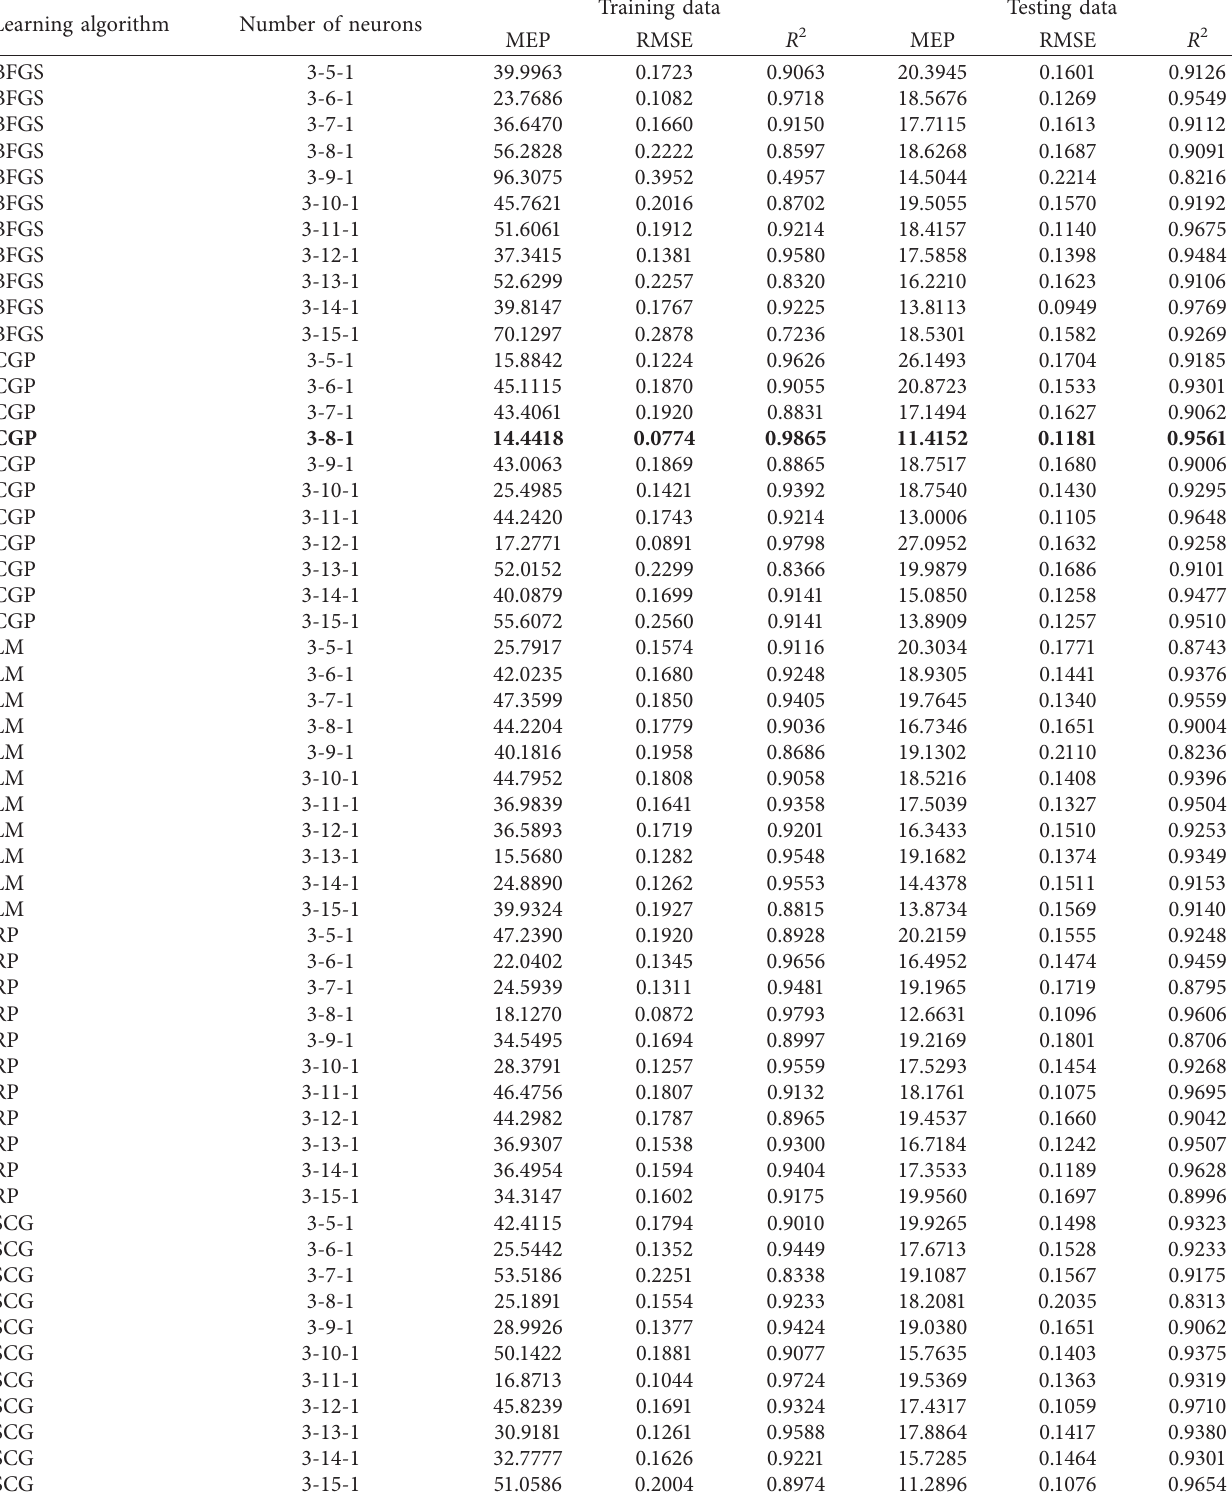
Table 3: Statistical data of the surface roughness for five learning